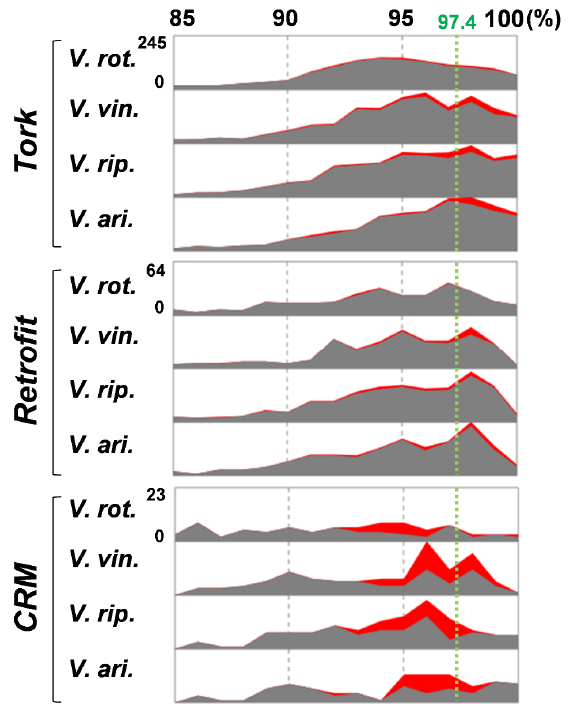
Figure 6. Activity history of LTR retrotransposon families involved in HT. The relative activity history of the three LTR retrotransposon families, Tork , Retrofit , and CRM , is presented. The activity history for the native LTR retrotransposons is shown with gray graphs, and that for paralogs of the horizontally transferred elements is shown with red graphs. The range of the X-axis is shown at the top of the panel. The estimated speciation point of V. rotundifolia is indicated with green dotted lines, and its identity value is shown at the top of the line. The range of the Y-axis is shown on the left side of each panel, and the range is the same as that of the other three Vitis species. The abbreviations are the same as in Figure 5.